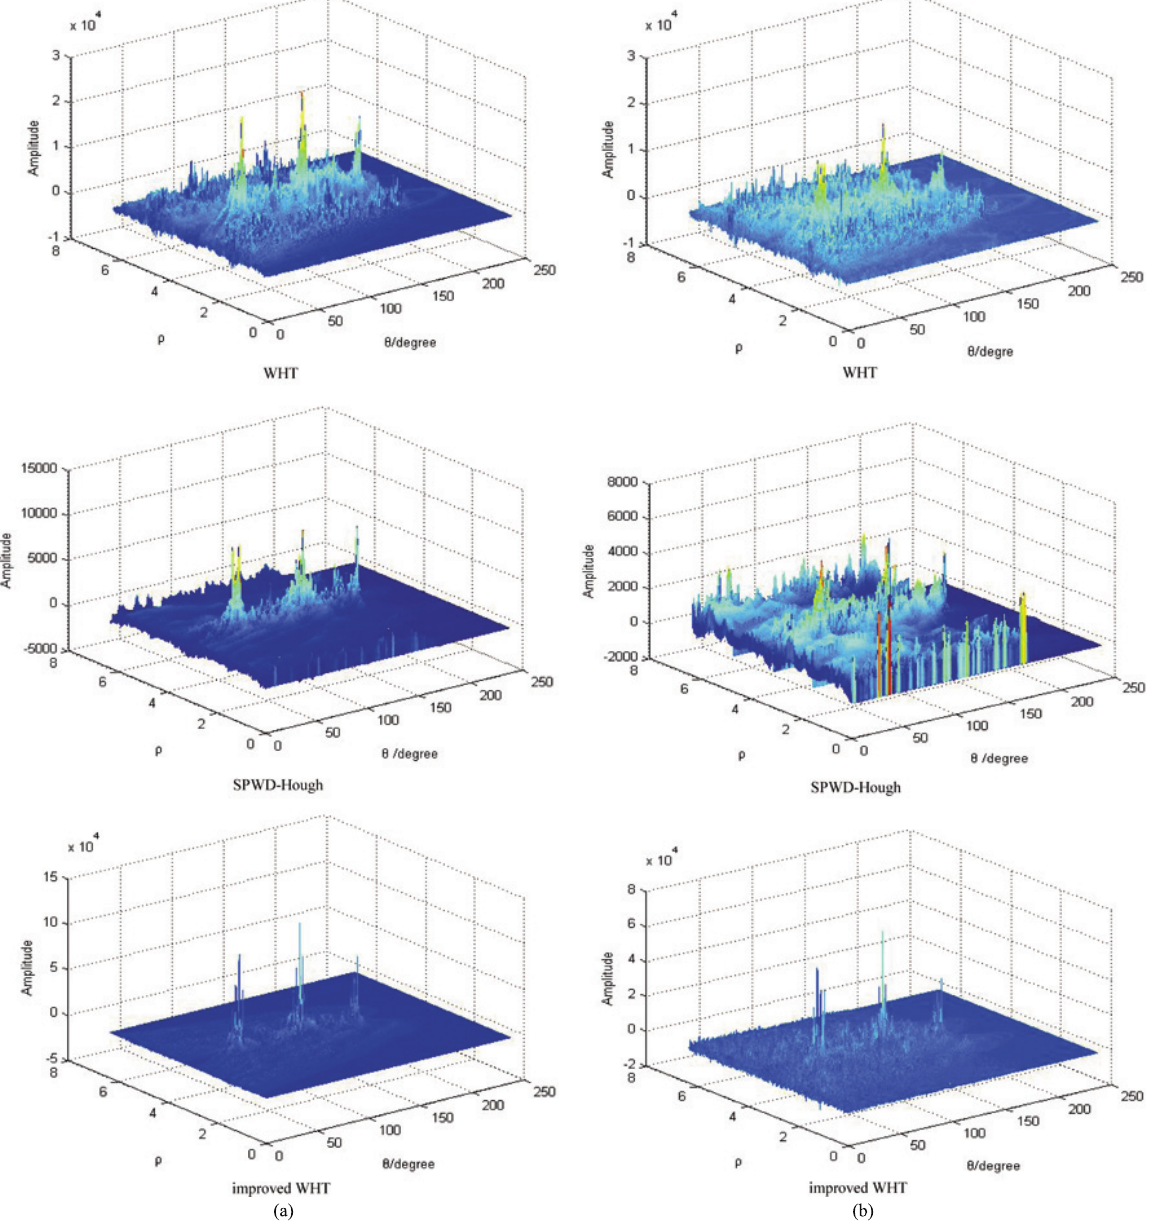
Fig. 2. Feature extraction of simulated signal with different SNR using 3 kinds of method (a) SNR = 10 dB (b) SNR = 0 dB (c) SNR = − 10 dB. X k was amplitude of the k order harmonic component of meshing frequency. H was the number of polynomial terms in Eq. (7). ϕ k was the initial phase of k order harmonic component of meshing frequency, f z was pivot frequency, z was the number of teeth gears. d k ( t ) and b k ( t ) were modulation function of amplitude and phase. When gear have partial fault, the meshing was put into gear with axis every turn. So d k ( t ) and b k ( t ) were periodic function with rotational frequency of f z and its harmonics as repeated frequency, i ( t ) was noise function.In simulation signal Eq. (7) as follows: H = 2 , X = 1 . 0 , X 2 = 0 . 4 , d 1 ( t ) = 0 . 2 sin(2 πf z t ) , d 2 ( t ) = 0 . 2 sin(4 πf z t ) , b 1 ( t ) = ) , b ( t ) = 0 . 2 sin(4 πf ) , ϕ = ϕ = π/ 6 , z = 18 , f = 20 Hz. The sampling frequency 0 . 2 sin(2 πf 2 1 2 z t z t z